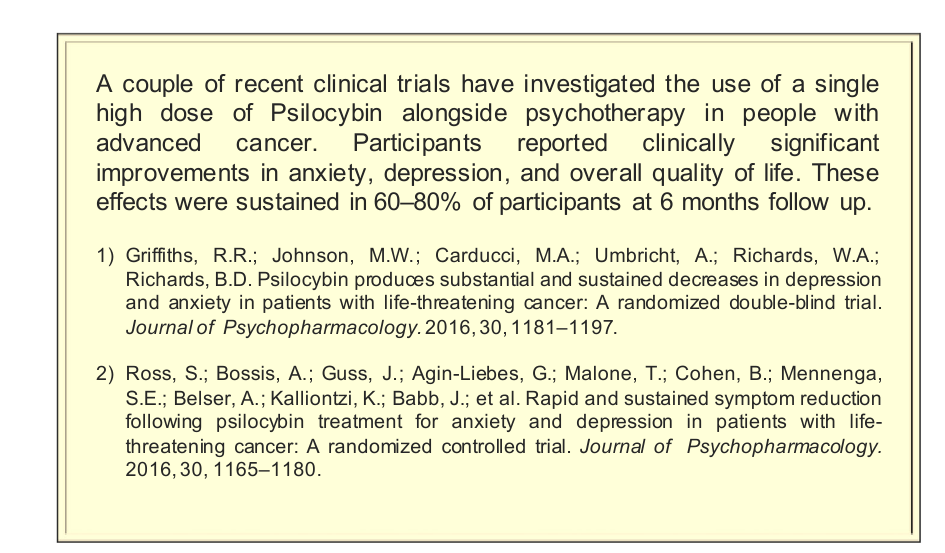
Figure Figure 1. Card with summary of research investigating psychedelic-assisted therapy with cancer patients.